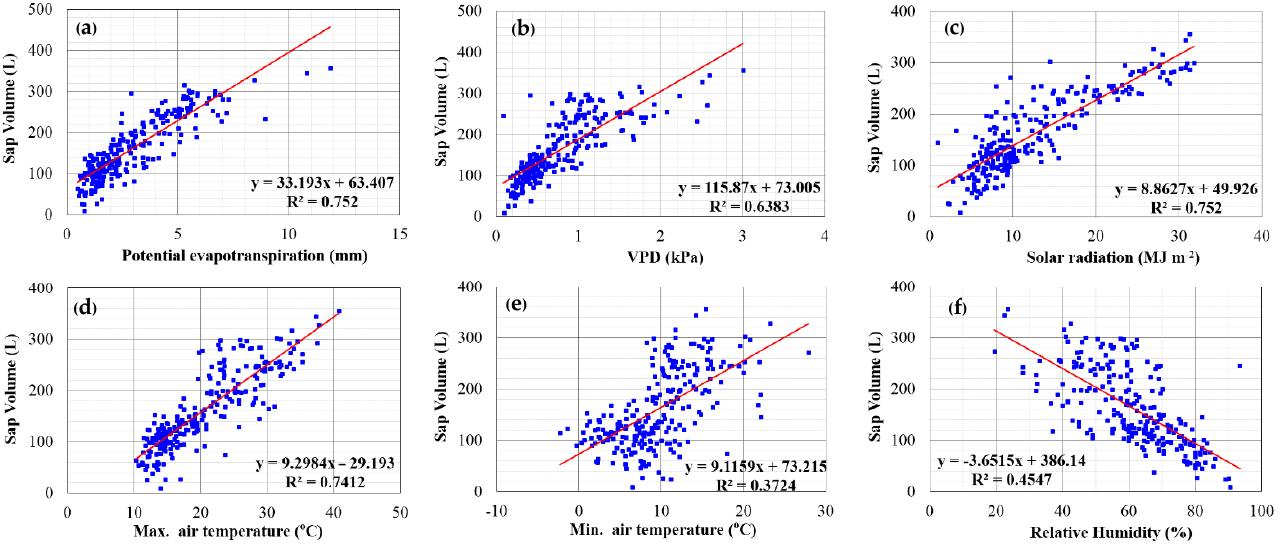
Figure 11. Relationship between sap flow volume in M. styphelioides and weather parameters ( a ) sap flow versus potential evapotranspiration; ( b ) sap flow versus VPD; ( c ) sap flow versus solar radiation; ( d ) sap flow versus Max. air temperature; ( e ) sap flow versus Min. air temperature; ( f ) sap flow versus relative humidity.